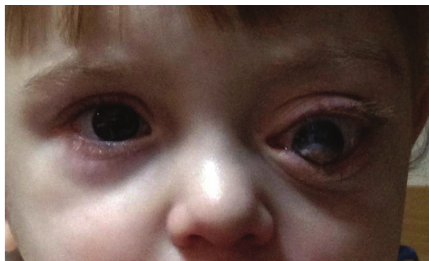
Figure 5: Appearance at 12 months of age.